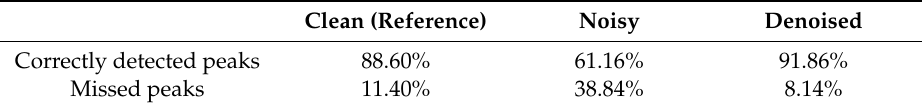
Table 5. Peak detection results on clean (reference), noisy, and denoised sequences. Clean (Reference) Noisy Denoised Correctly detected peaks 88.60% 61.16% Missed peaks